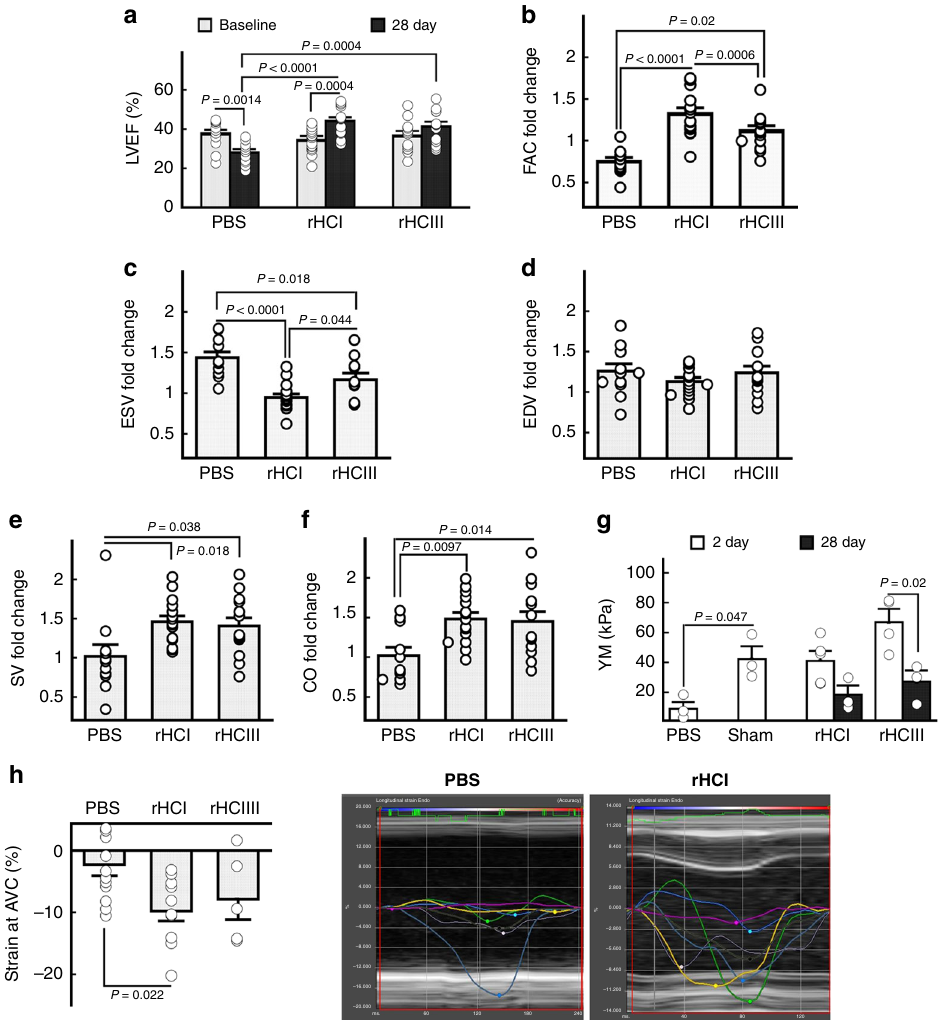
Fig. 2 rHC matrices improve cardiac function post-MI and restore mechanical properties. a Left ventricular ejection fraction (LVEF) at baseline (time of treatment delivery) and at 28 days post treatment ( n = 11 for PBS, n = 15 for rHCI, and n = 13 for rHCIII). Signi fi cance determined by a two-way ANOVA followed by Holm ’ s correction for multiple comparisons. b – f The change in ( b ) fractional area change (FAC), ( c ) end-systolic volume (ESV), ( d ) end- diastolic volume (EDV), ( e ) stroke volume (SV), and ( f ) cardiac output (CO) between baseline and 28 days post-treatment ( n = 11 for PBS, n = 15 for rHCI, and n = 13 for rHCIII). P- values were determined by an ANOVA followed by Holm-corrected multiple comparisons. g Young ’ s modulus (YM) for scar/ border zone tissue measured at 2 and 28 days ( n = 3 – 4). h Left: Strain force reached at the aortic valve closure within the mid anterior LV wall at 2 days post injection for the different experimental groups ( n = 5 – 12). Right: Representative longitudinal strain curves for the PBS and rHCI groups. The yellow traces correspond to the anterior mid region. Signi fi cance determined by a one-way ANOVA followed by Dunnett ’ s comparison as well as a two-tailed Student ’ s t test within a treatment group over time. The data are presented as the mean ± SEM. Source data are provided as a Source Data fi le. For a – h , n indicates the number of mice per